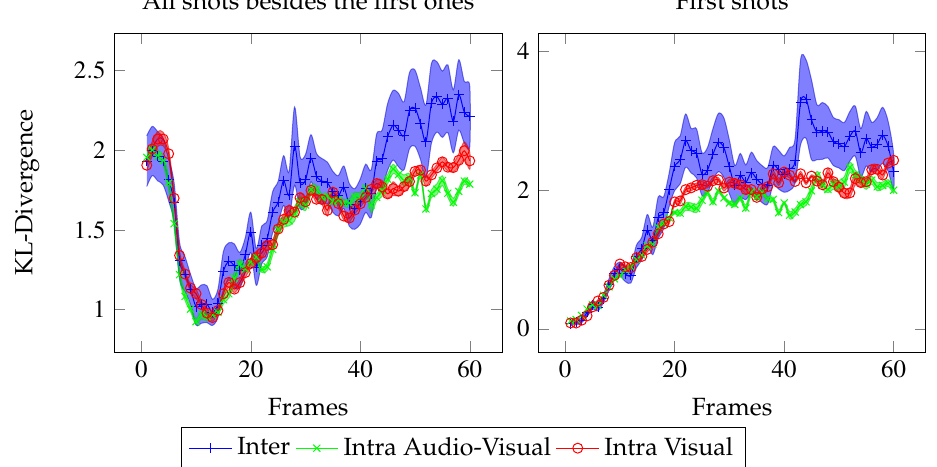
Figure 5 . Temporal evolution of the KL-divergences between and within the eye positions of each stimulus condition, aver- aged over all shots except the first ones (113 shots, left) and over the first shots (50 shots, right). In blue, the KL-divergence between the V and AV conditions. In red, the KL-divergence within the V condition. In green, the KL-divergence within the AV condition. For the inter KL-divergence, the error bars are standard errors. For the intra KL-divergences, the error bars are calculated on the KL-divergence values averaged over the ten random sets of eye positions within each stimulus condition.